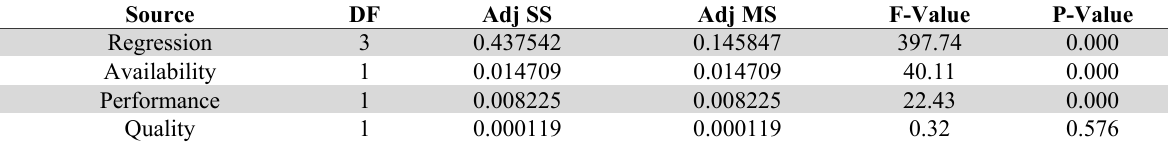
Linear Regression Analysis